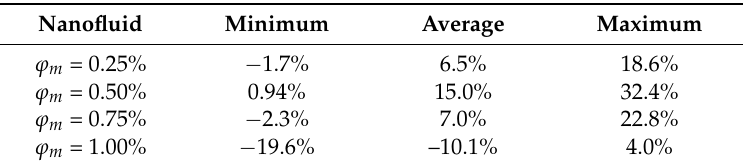
Table 1. Heat transfer enhancement with respect to water for functionalized graphene nanoplatelet aqueous nanofluids.